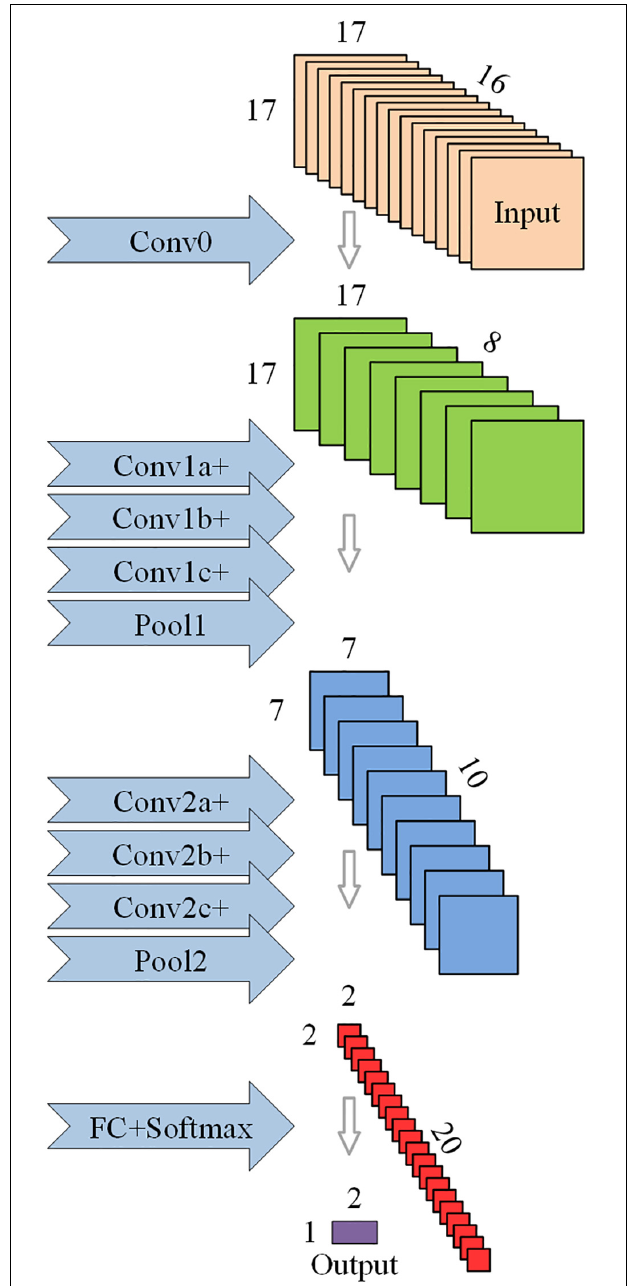
FIGURE 2 | Schematic diagram of the structure of the optimized convolutional neural network (opt-model).